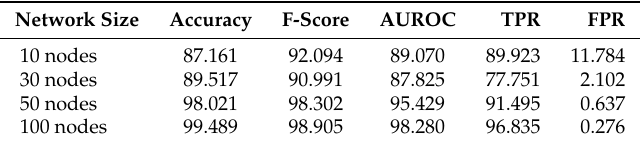
Table 4. Cluster-based detection performance per network size (Max speed of 20 m/s).